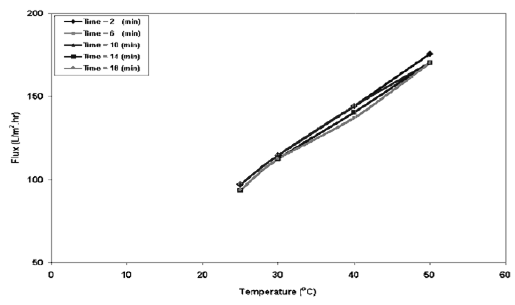
Fig. 5. E dye. Δ P=